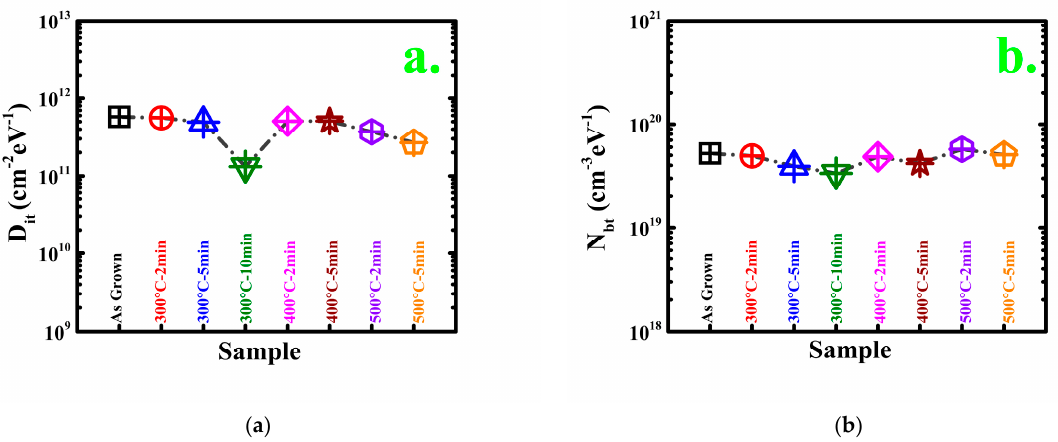
Figure 4. ( a ) Interface trap comparison and ( b ) border trap comparison for all